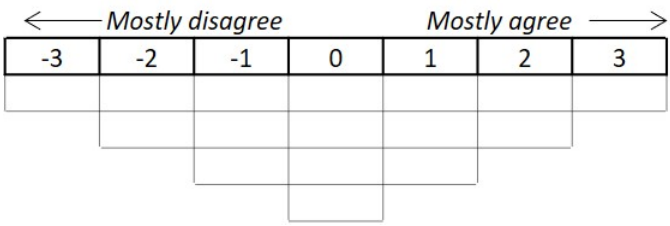
Figure 3. Model of forced rating scheme and number of statements used in this study (note how the model achieves a standard distribution in terms of level of agreement among the number of statements, 16 in this case).